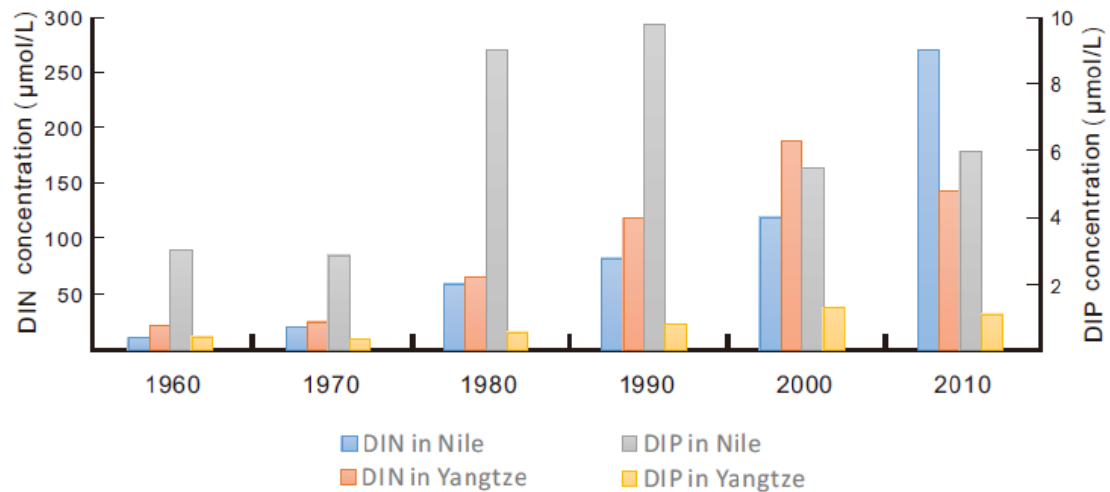
Figure 4. N- and P-concentration of the Yangtze estuary was re-calculated from [25], and that of the Nile estuary was recalculated from [12,14,15].